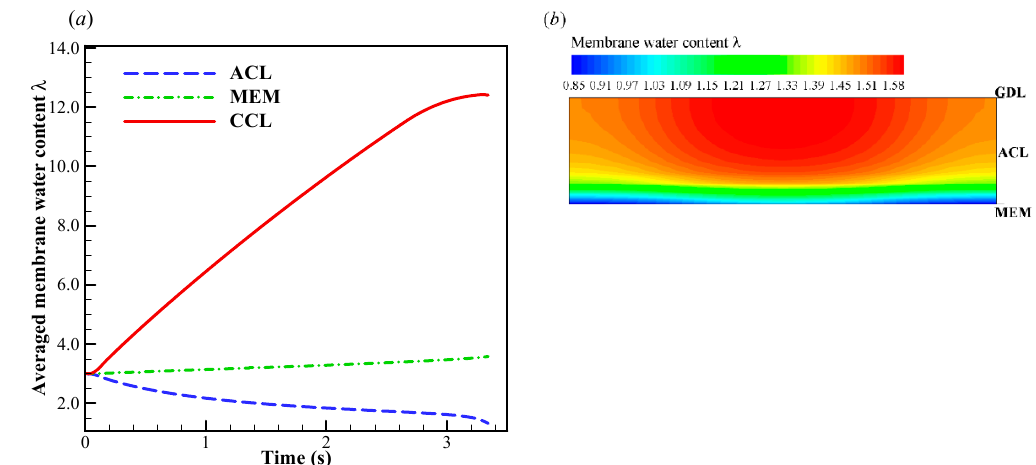
Figure 6. ( a ) Evolution of the volume-averaged membrane water content and ( b ) the contour of membrane water content on midway cross section (Z = 25 mm) of ACL when the cell shuts down. The cell starts from − 20 ◦ C and the startup current density is 0.210 A / cm 2 . The cell is supplied with dry hydrogen and oxygen. The stoichiometry ratio of the mass flow rate is 2.0 for both anode and cathode sides. The background pressure is 1.0 atm at both the anode and cathode outlets.